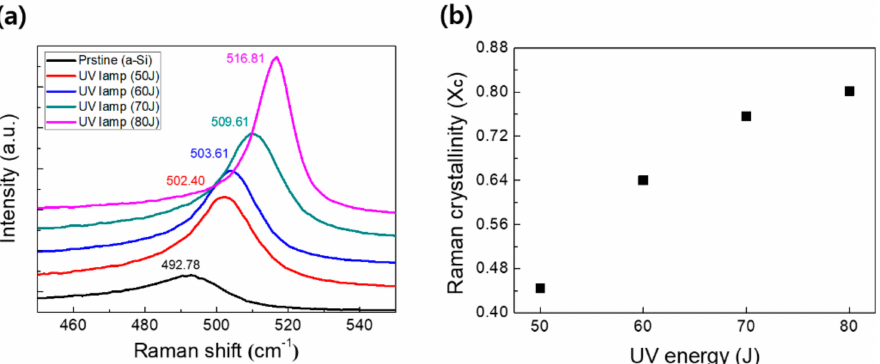
Figure 4. ( a ) Raman spectra and ( b ) Raman crystallinity (X c ) of a-Si after the crystallization with different UV energies (50~80